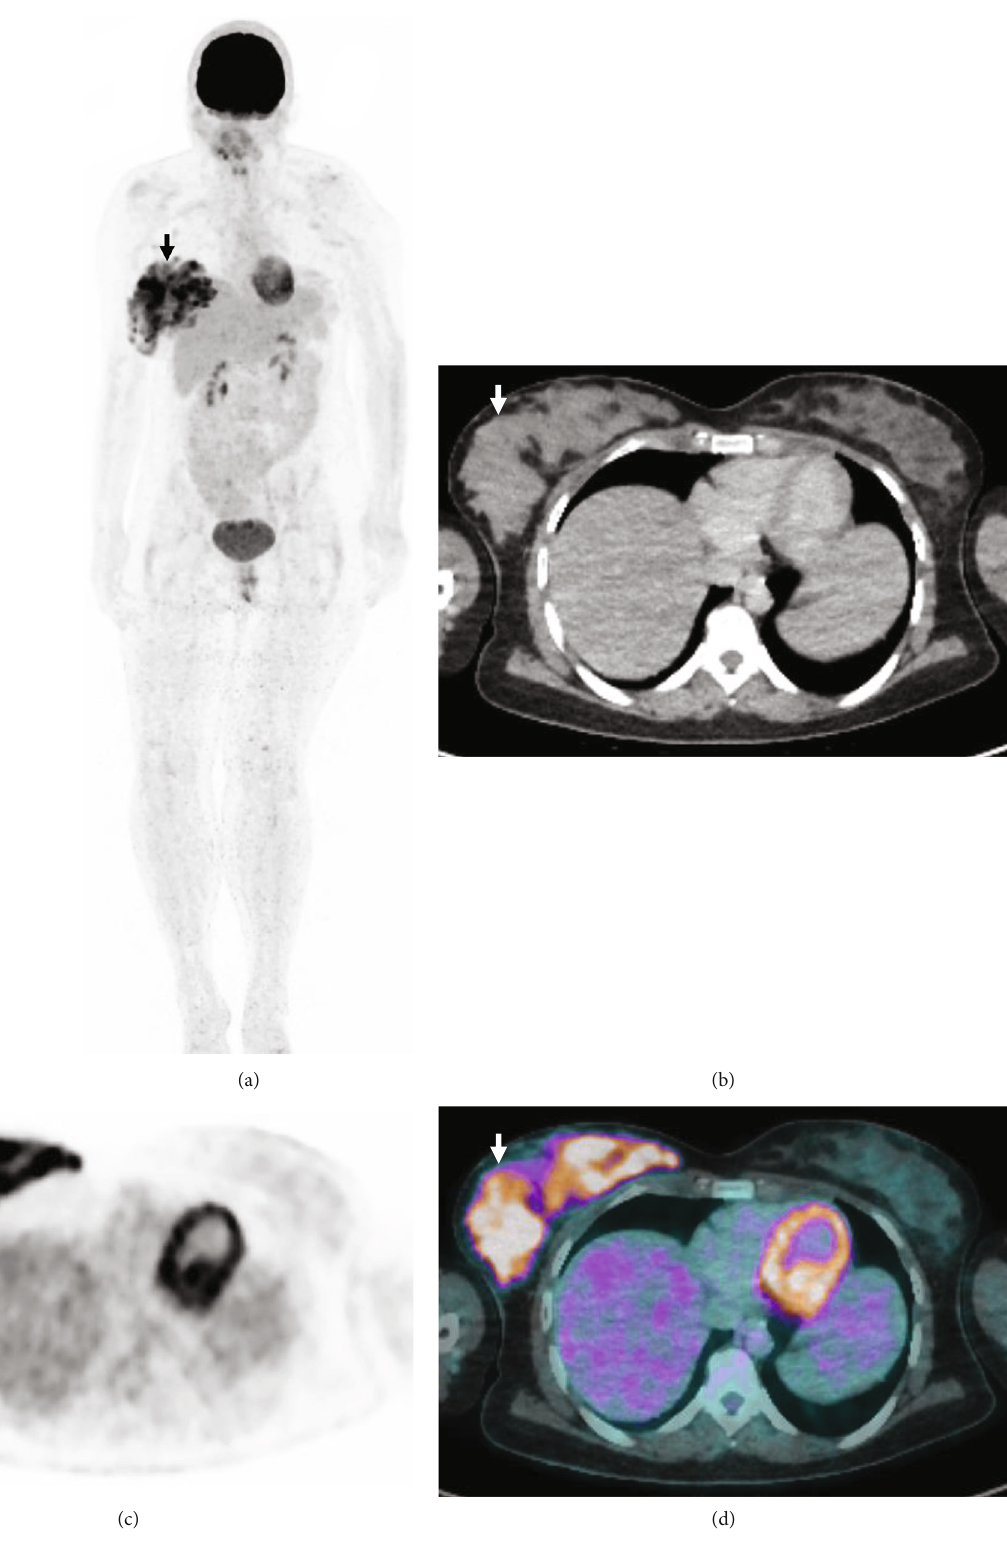
Figure 1: The maximum intensity projection (a) image demonstrates unilateral di ff use intense FDG uptake in the right breast (arrow). Axial low dose CT (b), FDG PET (c), and fused FDG PET/CT (d) images demonstrate unilateral di ff use intense FDG uptake (SUVmax up to 12.8) corresponding to dense soft tissue in the right breast